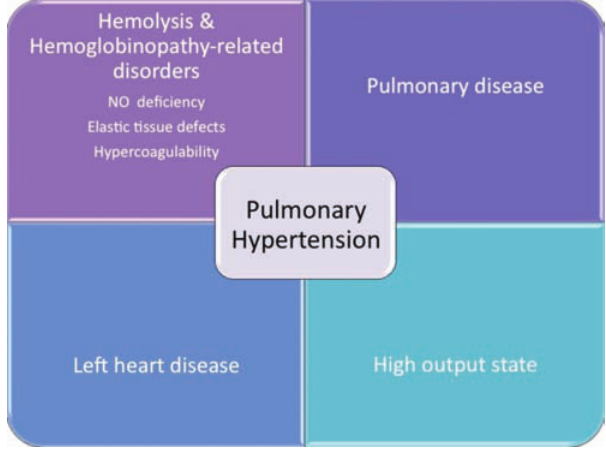
Figure 1. Main pathogenetic mechanisms of pulmonary hyperten- sion in